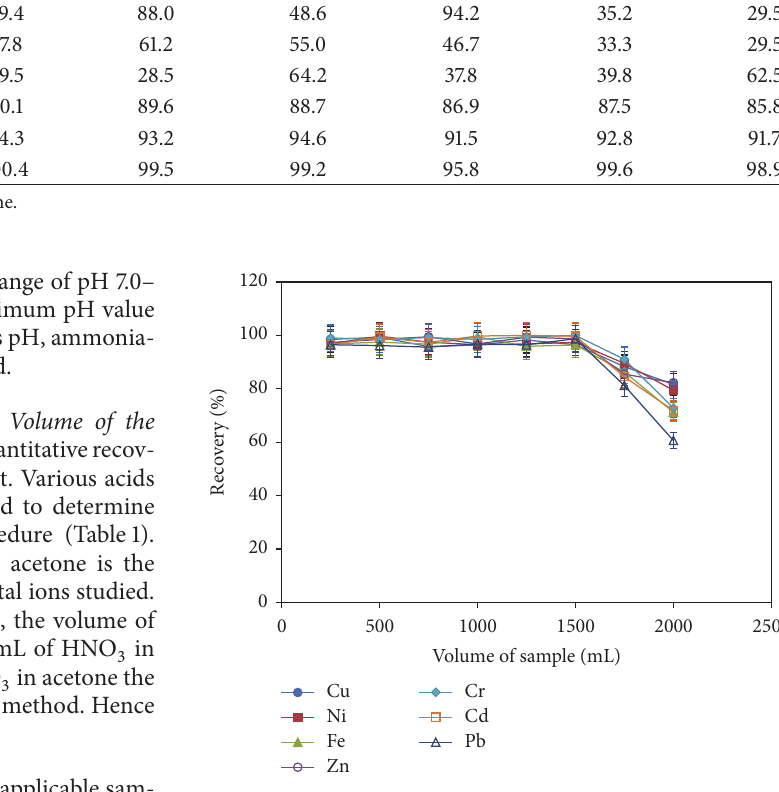
metal ions are not quantitatively recovered without